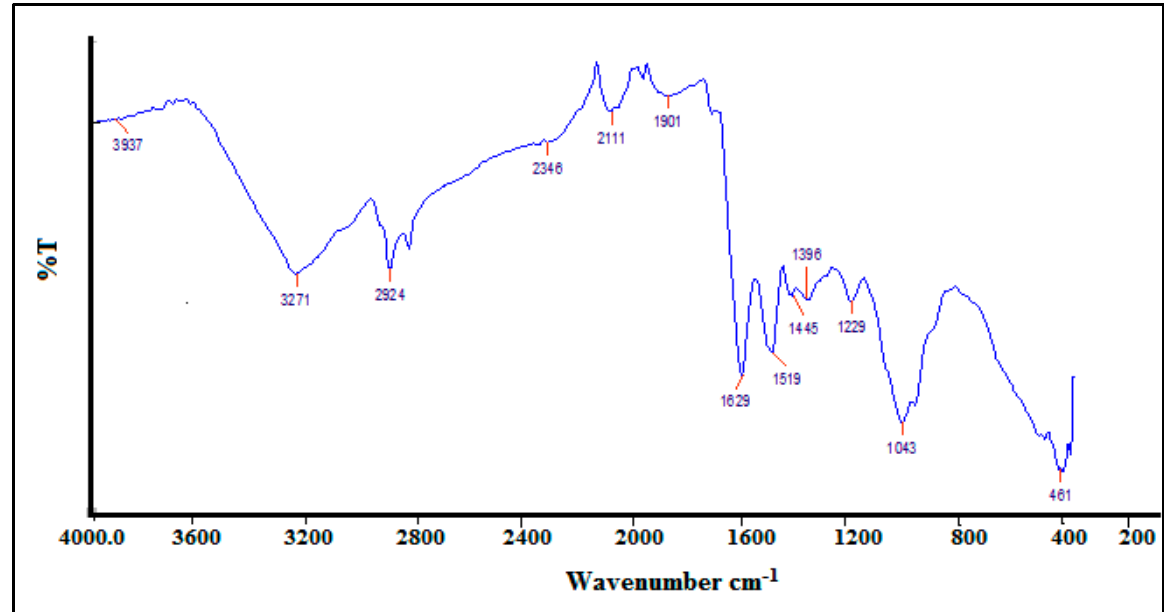
Figure 4. FTIR spectrums of AgNPs synthesized by S. officinarum extract.